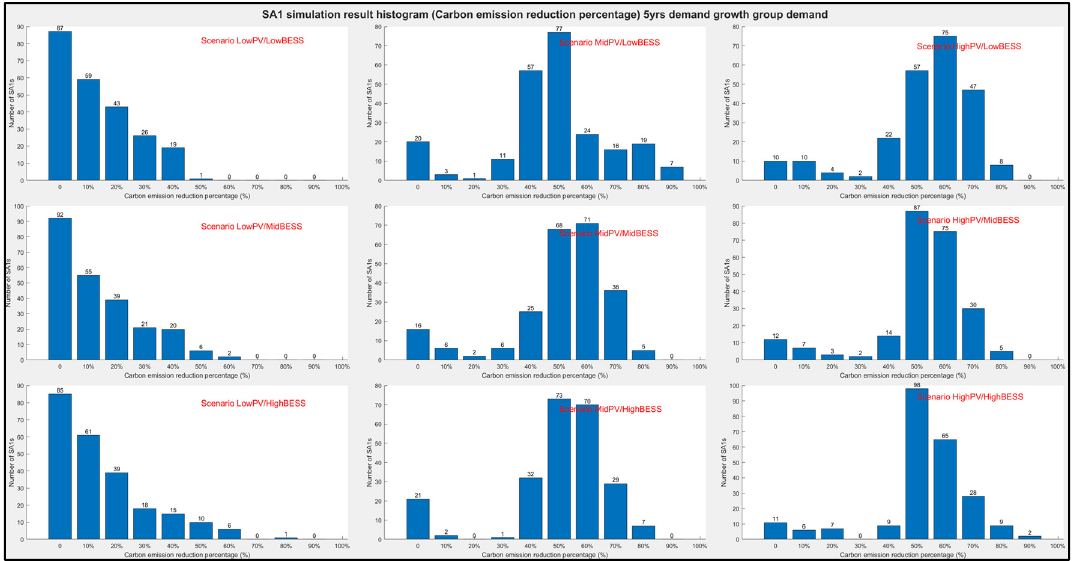
Figure 8. Histogram plots of SA1 simulation results for carbon emission reduction rate.